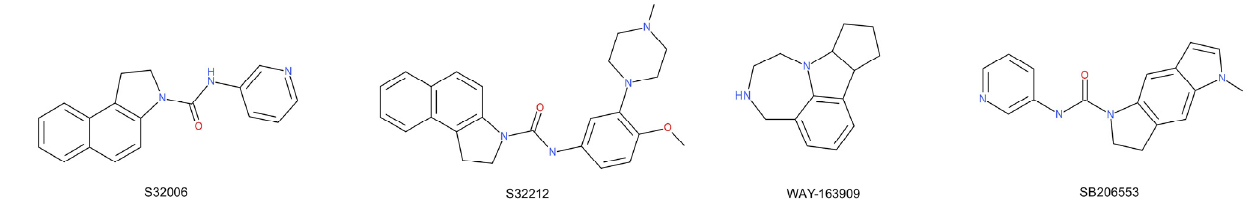
Figure 6. 5-HT 2C receptor ligands: S32006, S32212, WAY-163909 and